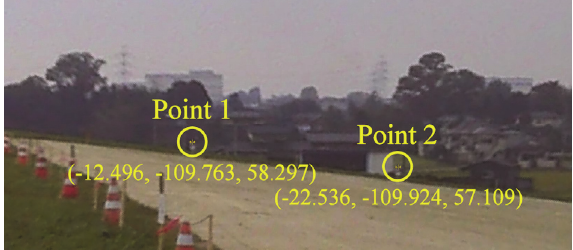
Figure 17. Verification of TLS by distance measurement